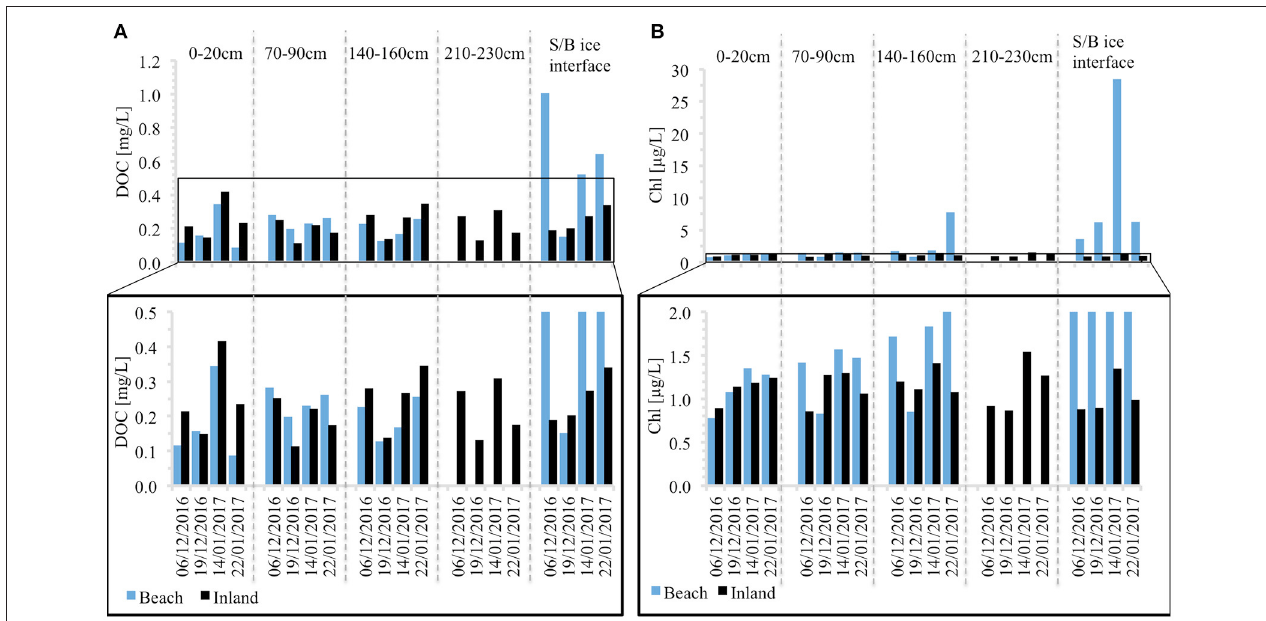
FIGURE 5 | Snowpack (A) Dissolved organic carbon (DOC); and (B) in-vivo chlorophyll concentration. For clarity the graphs at the bottom show variability at the lower end of each scale.